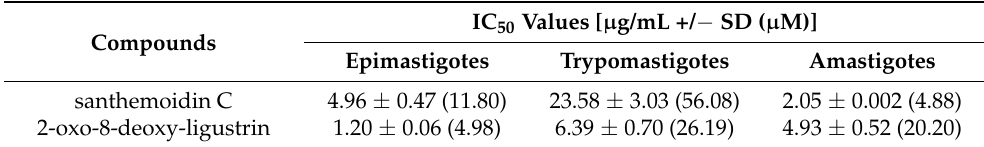
Table 1. IC 50 values calculated for each compound against the three forms of T. cruzi .